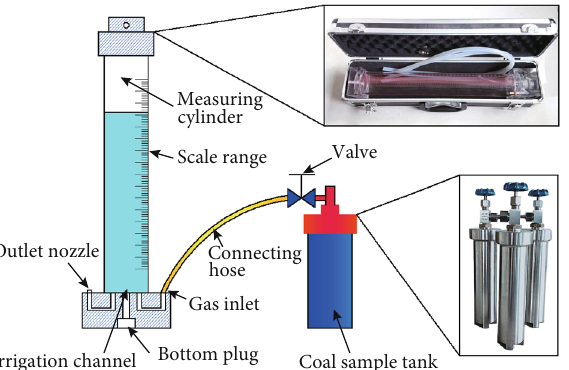
Figure 8: Schematic illustrating connection of DGC